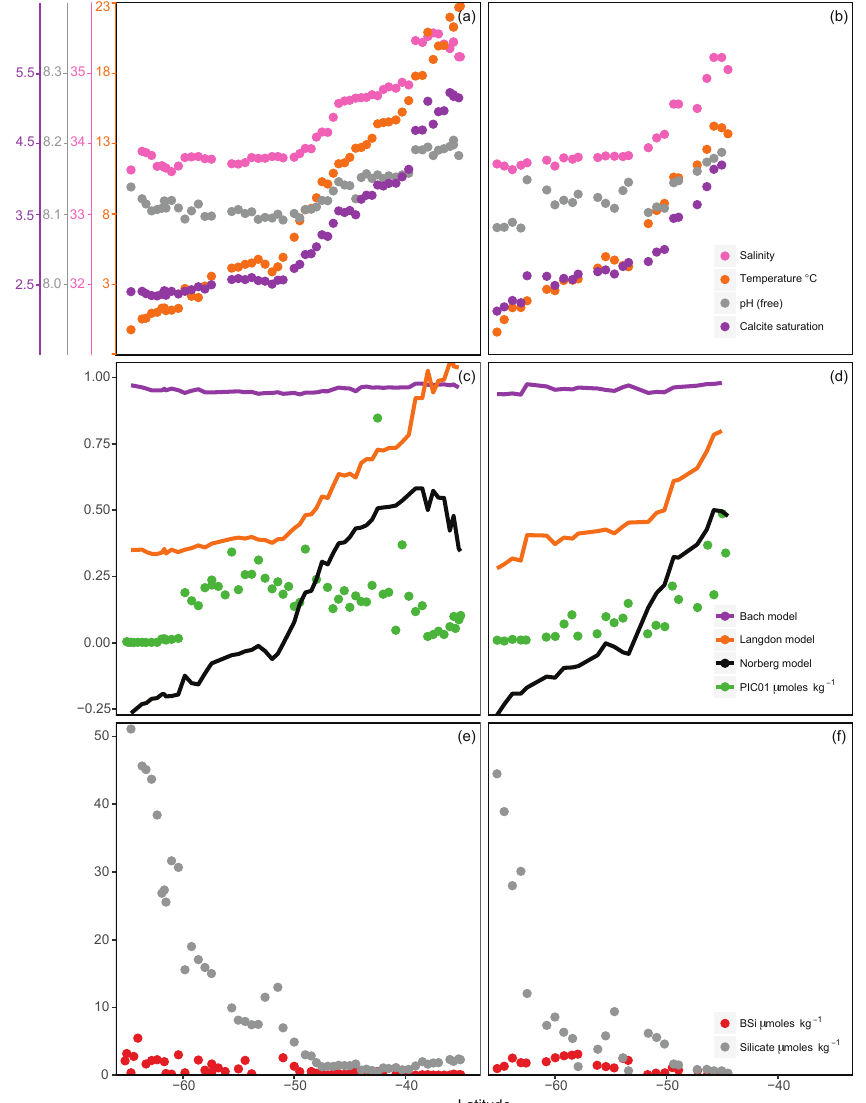
Figure 7. Latitudinal environmental conditions for voyage leg VL3 (left panels) and voyage leg VL6 (right panels): (a, b) T, S, pH (free scale), calcite saturation; (c, d) PIC01, Bach and Langdon relative calcification rate (dimensionless), and Norberg growth rate (d − 1 ) models; (e, f) BSi and Si ( OH ) 4 concentrations